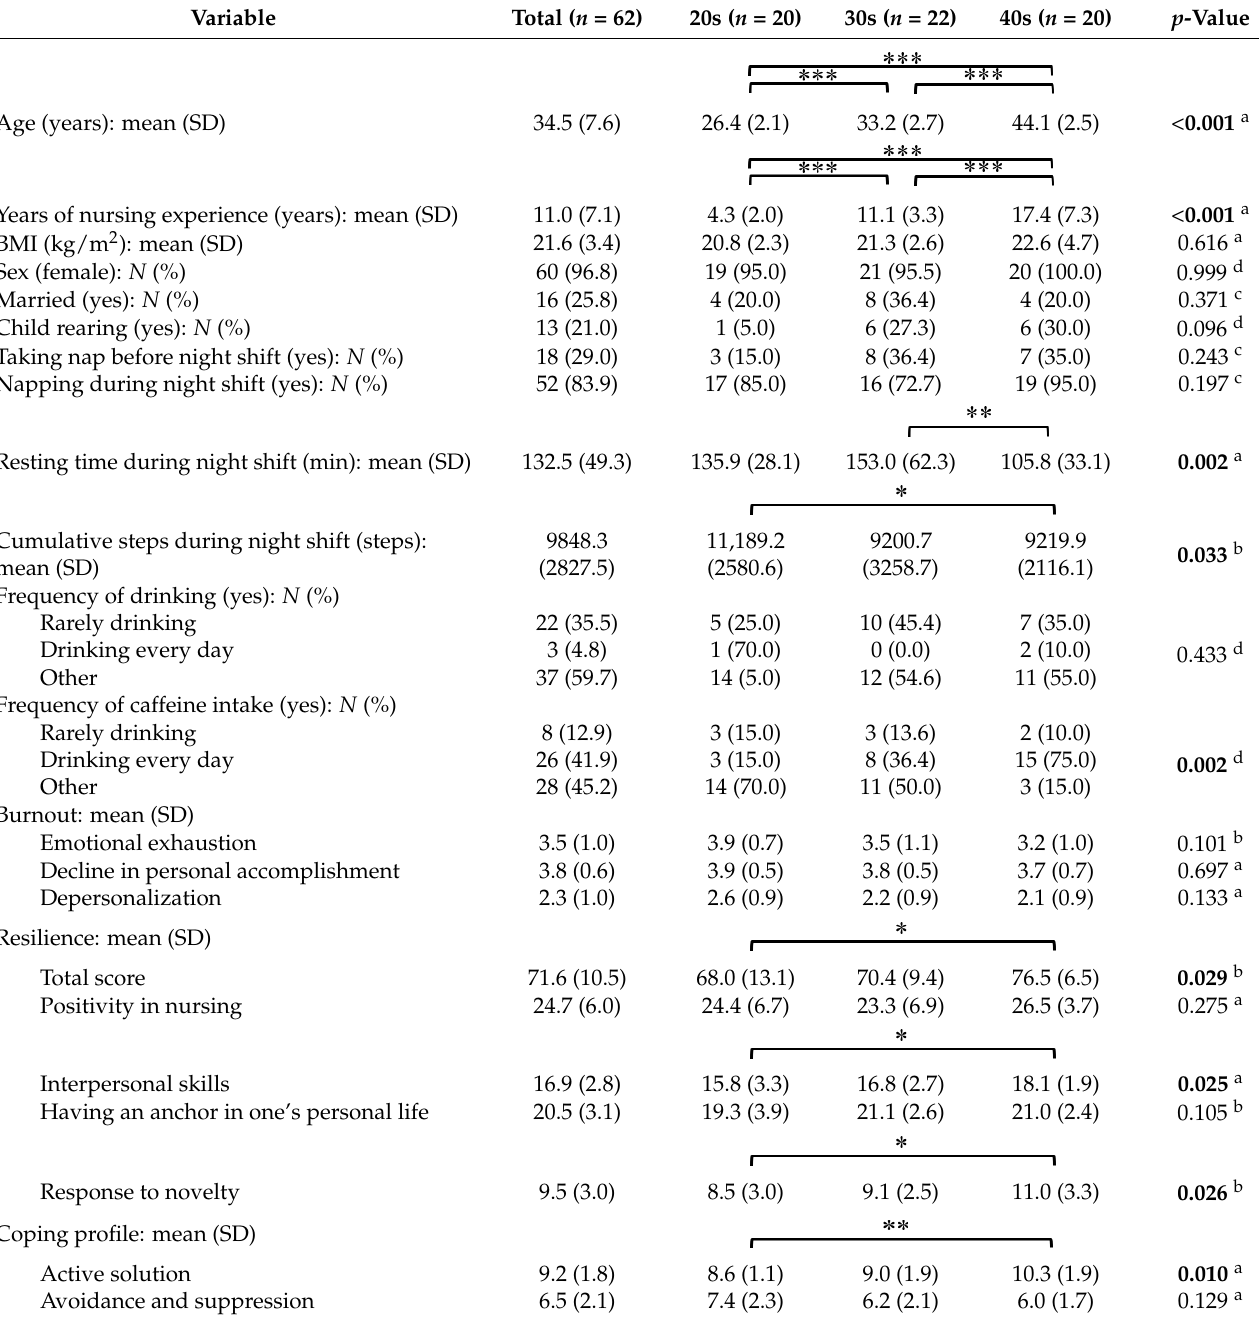
Table 1. Demographic, work environment, and psychological characteristics of participants.